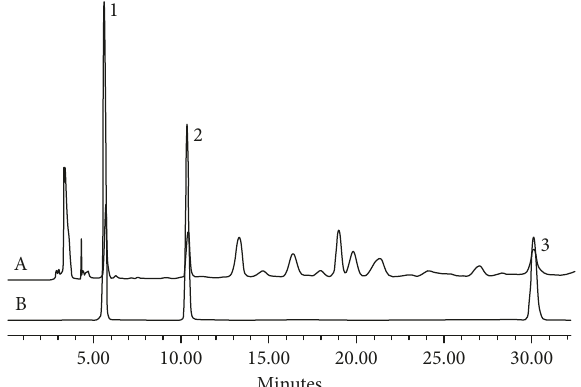
Figure 3: The HPLC chromatogram of C. songaricum ; A: crude drugs; B: reference standard; 1: gallic acid; 2: protocatechuic acid; and 3: catechin.